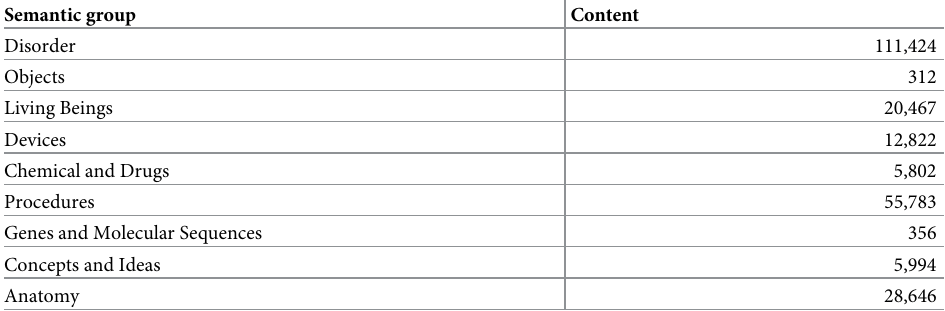
Table 1. Number of concepts associated with each semantic group and extracted from SNOMED CT to create the terminology